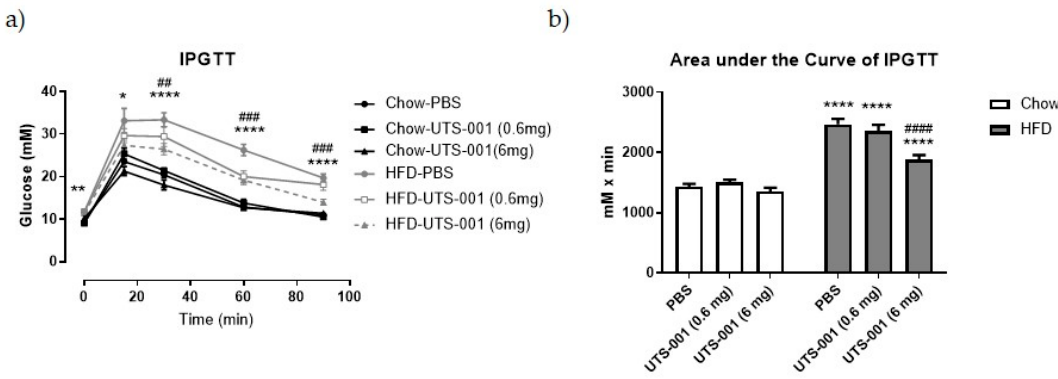
Figure 1. ( a ) An intraperitoneal glucose tolerance test (IPGTT, glucose 2 g / kg) after 4 weeks of treatment. ( b ) Area under the curve (AUC) of the IPGTT in ( a ). Data are expressed as mean ± S.E.M, n =